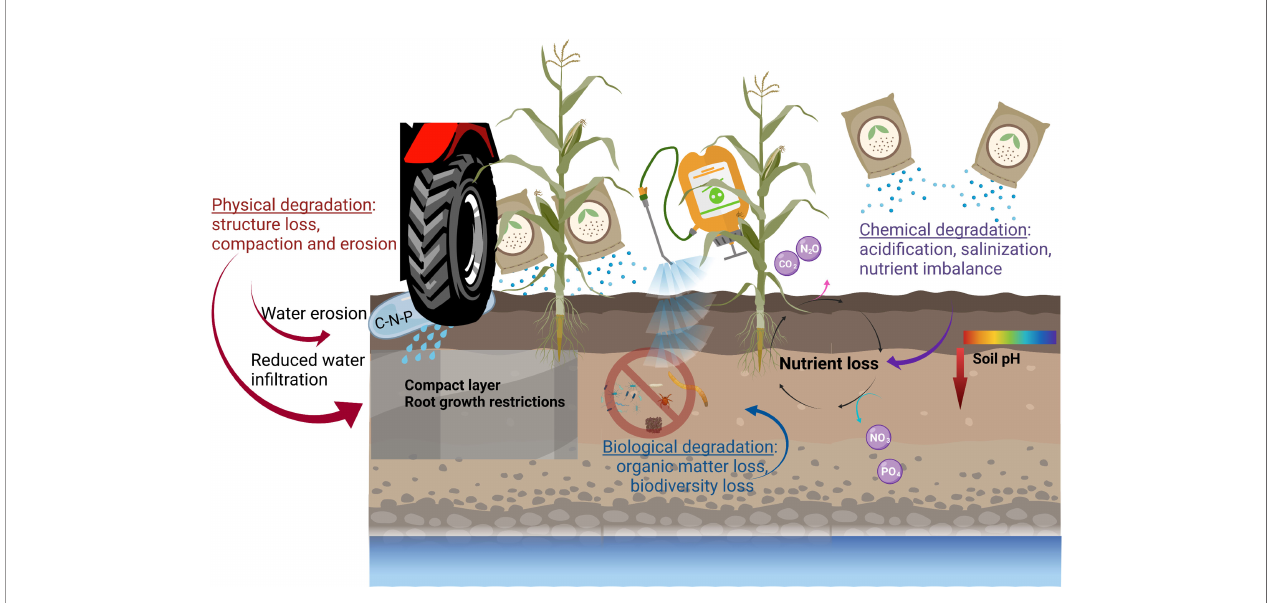
FIGURE 1 | Soil degradation in an agroecosystem. Physical degradation includes structure loss, compaction and erosion. These problems come with crop growth restriction (compact layer, aeration restriction) and overuse of fertilizer to compensate. Biological degradation includes the loss of organic matter and biodiversity often related to tillage intensity and frequency, poor crop rotation and soil coverage and heavy use of pesticides. Chemical degradation includes acidi fi cation, salinization and nutrient imbalance often related to heavy use of fertilizer, poor irrigation water quality and intensity of cropping